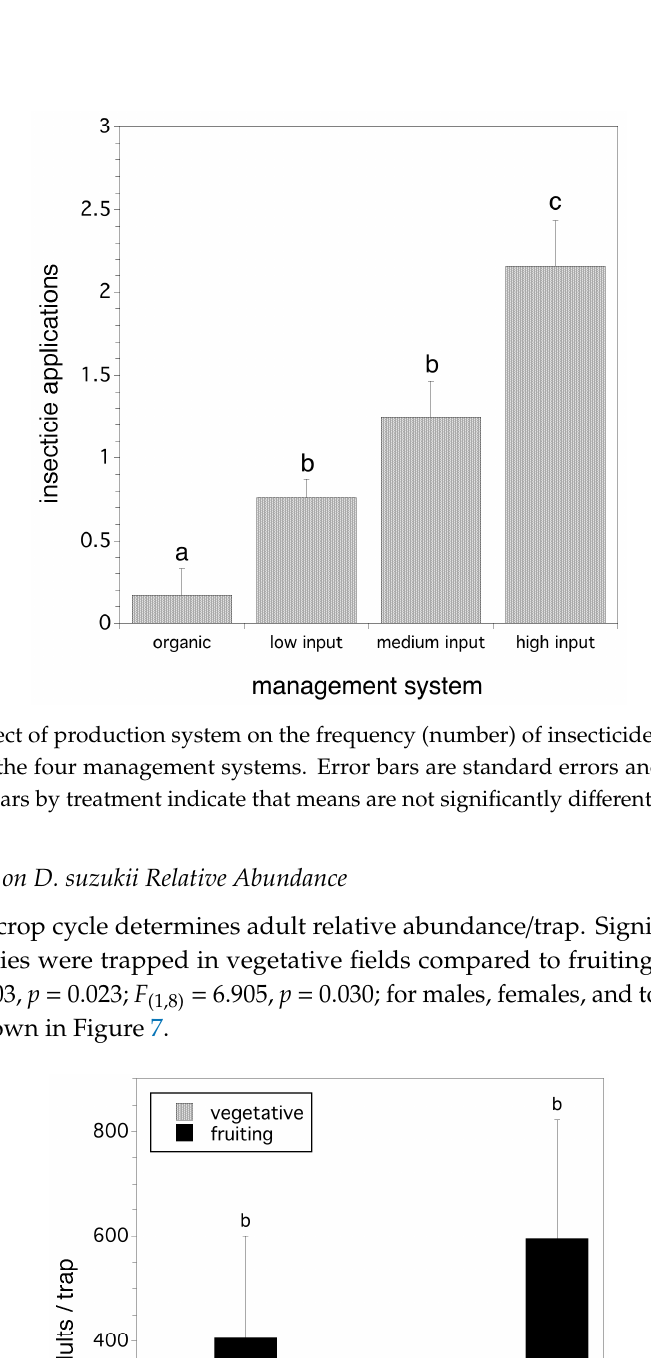
Figure 7. Adult trap captures in vegetative compared to fruiting fields. Error bars are standard errors and the same letters associated with bars by treatment indicate that means are not significantly different from one another ( p > 0.05).